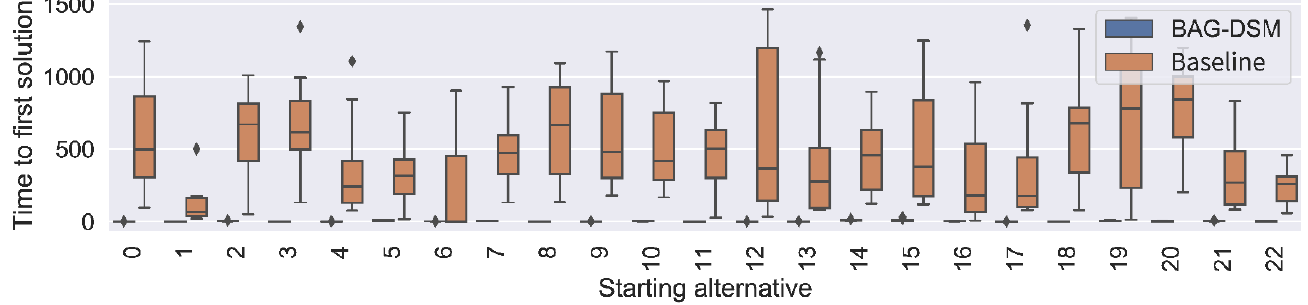
Figure 10. Boxplots for the time (shorter is better) required to find the first optimal alternative by BAG-DSM vs. baseline for the Landmark model. BAG-DSM vs. baseline for the Landmark